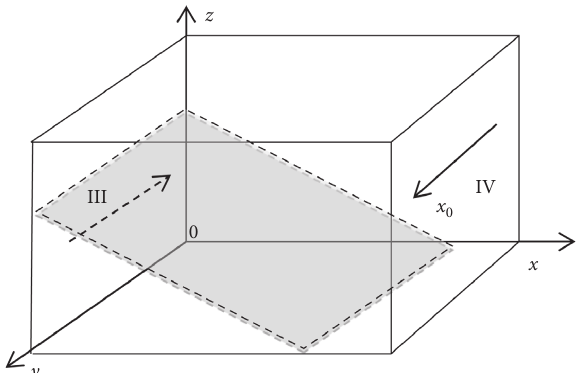
Figure 2: The platform’s dynamic evolutions.